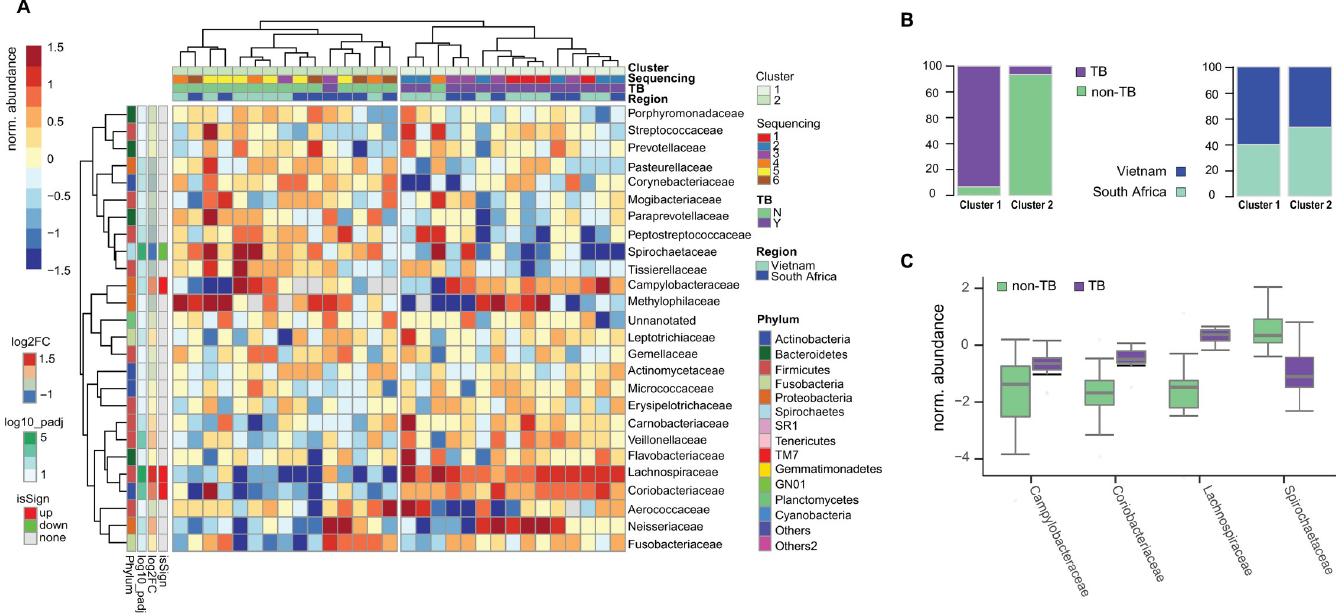
Fig 2. Analysis of the second batch of samples received from FIND. A. Heatmap of Family abundances across samples. The hierarchical clustering shows a segregation for the majority of the TB (violet) and non-TB samples (green). No segregation is observed for the sequencing batch or the region of origin. Annotations of rows provide the strengths and significances of Families in TB samples compared to non-TB samples (differential abundance analysis–see methods - significant if absolute log2 Fold-Change > 1 and adjusted p-value < 0.05). B. Barplots quantifying the representations of TB and non-TB samples in the two clusters obtained in A as well as their region of origin. C. Abundance distributions of representative Families identified in A in TB and non-TB